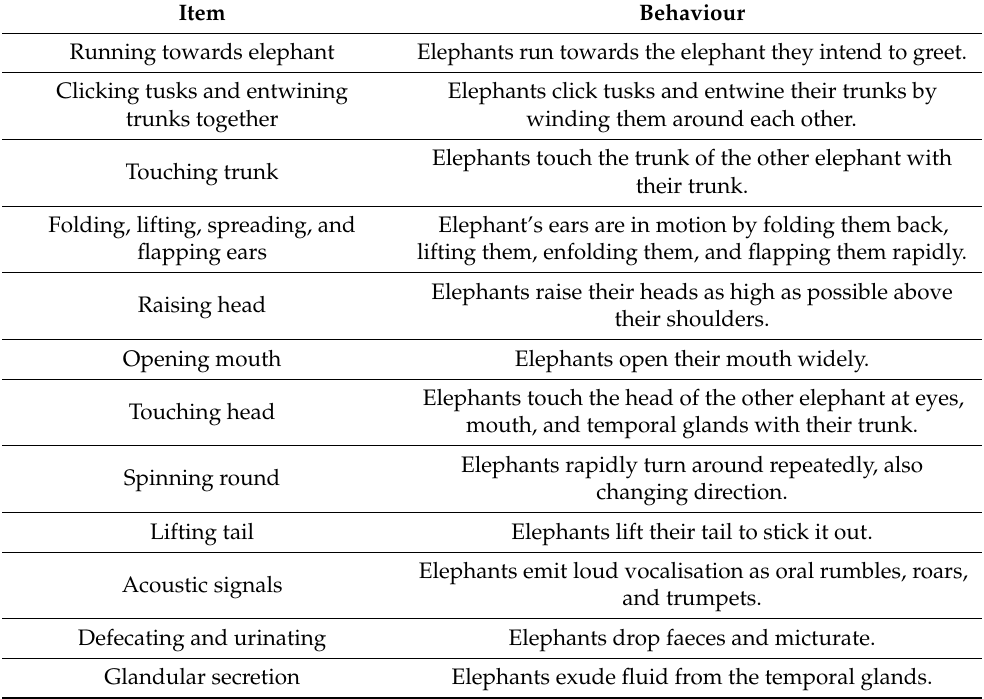
Table 1. Behaviour expressed during a Greeting Ceremony